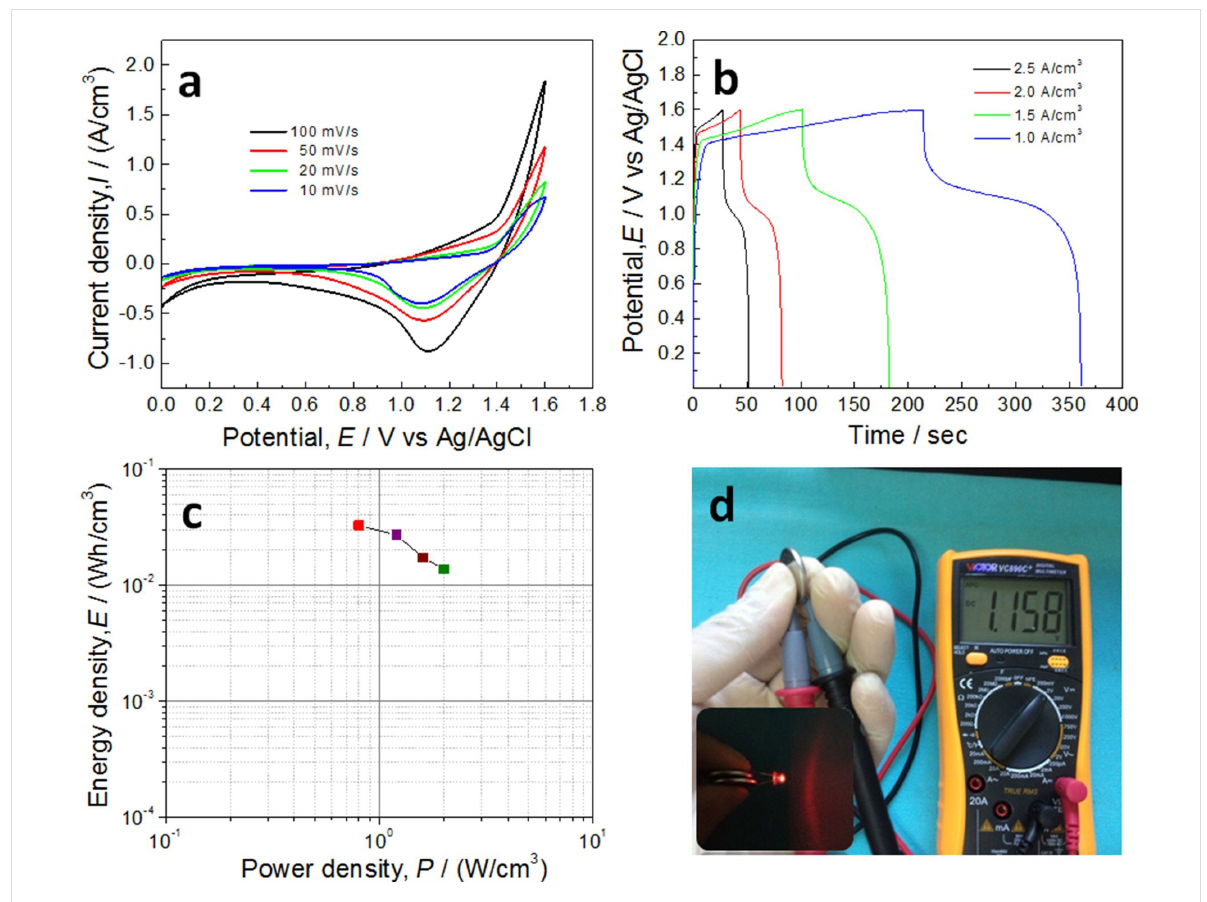
Figure 8: (a) CV curves and (b) GCD curves of a single SC device; (c) Ragone plot of the SC device; (d) voltage of a single fully charged device and a red LED bulb powered by two SC.